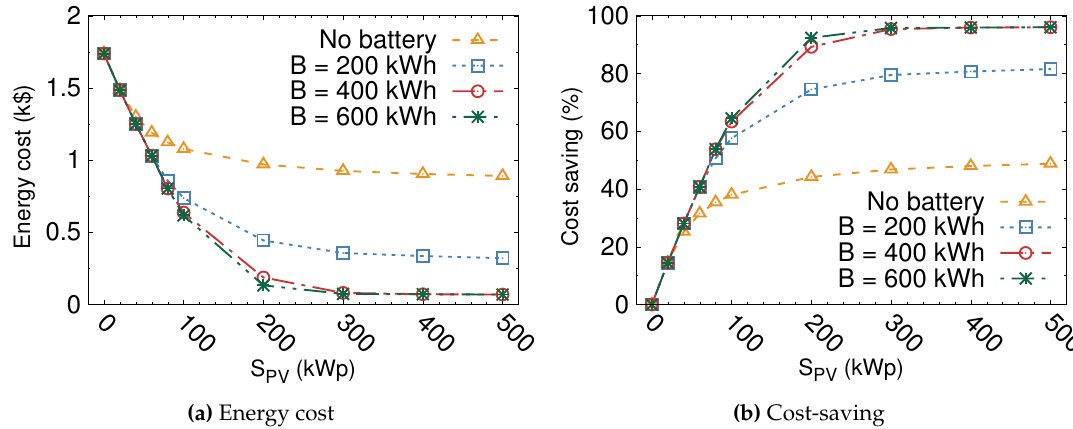
Figure 7. Energy cost and cost-saving. The DCs have the same PV panel size, reported on the x